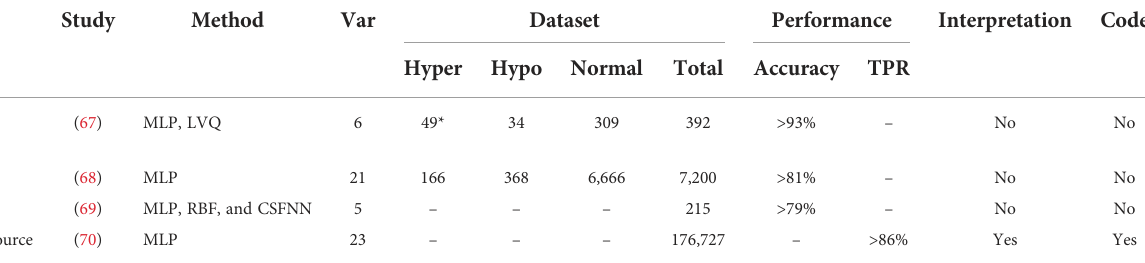
TABLE 4 DL-based studies for thyroid status